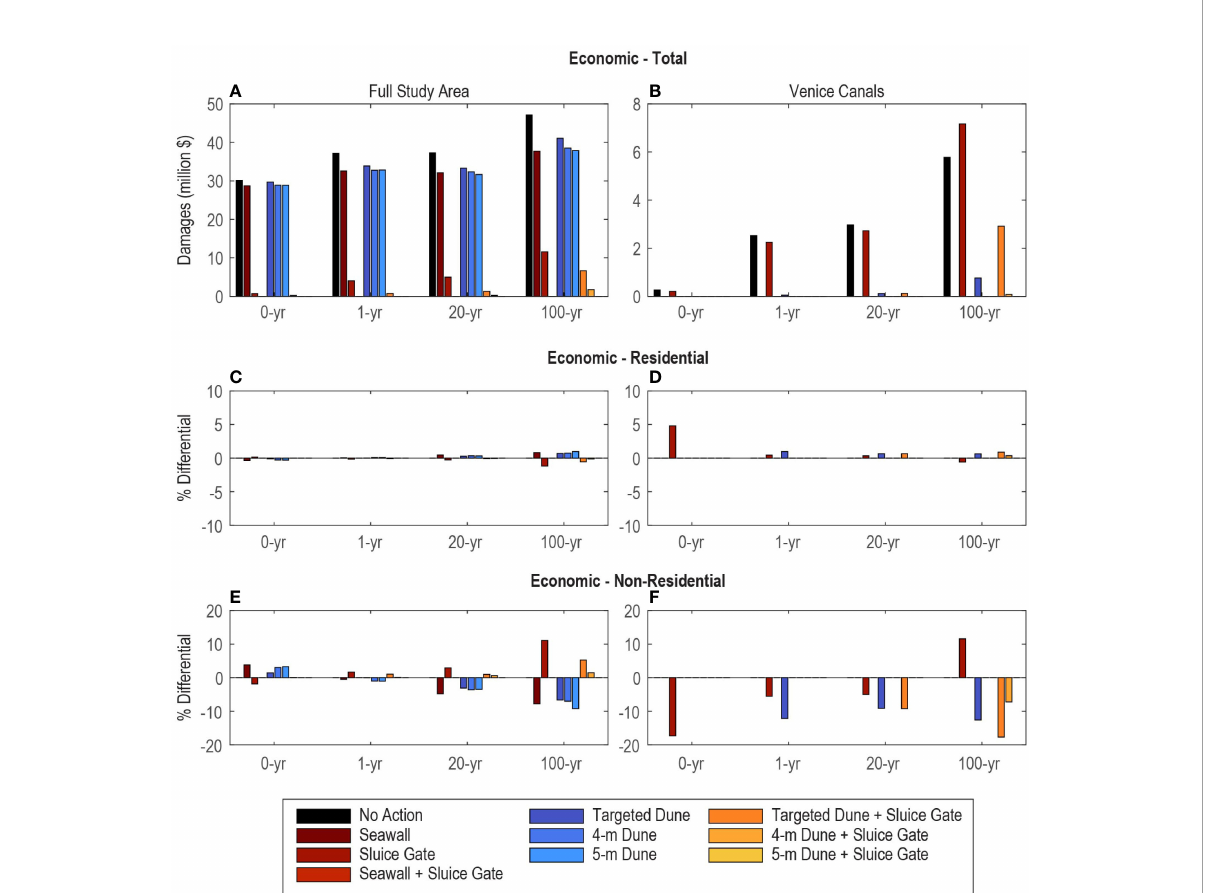
FIGURE 4 Simulated total damages (A, B) and percent differential for residential (C, D) and nonresidential (E, F) structures for each adaptation approach across the range of storm scenarios. Positive bars indicate a higher level of protection for the speci fi ed structure type as compared to the entire structure inventory, while negative bars represent a lower level of protection. Results for the full study area are shown in the left column and the Venice Canals in the right